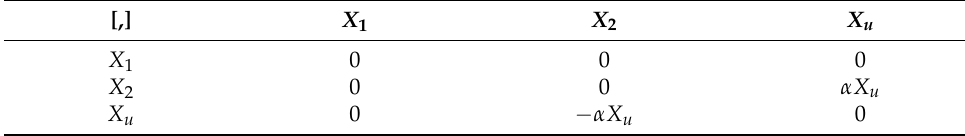
Table 2. Lie brackets for Case 1.